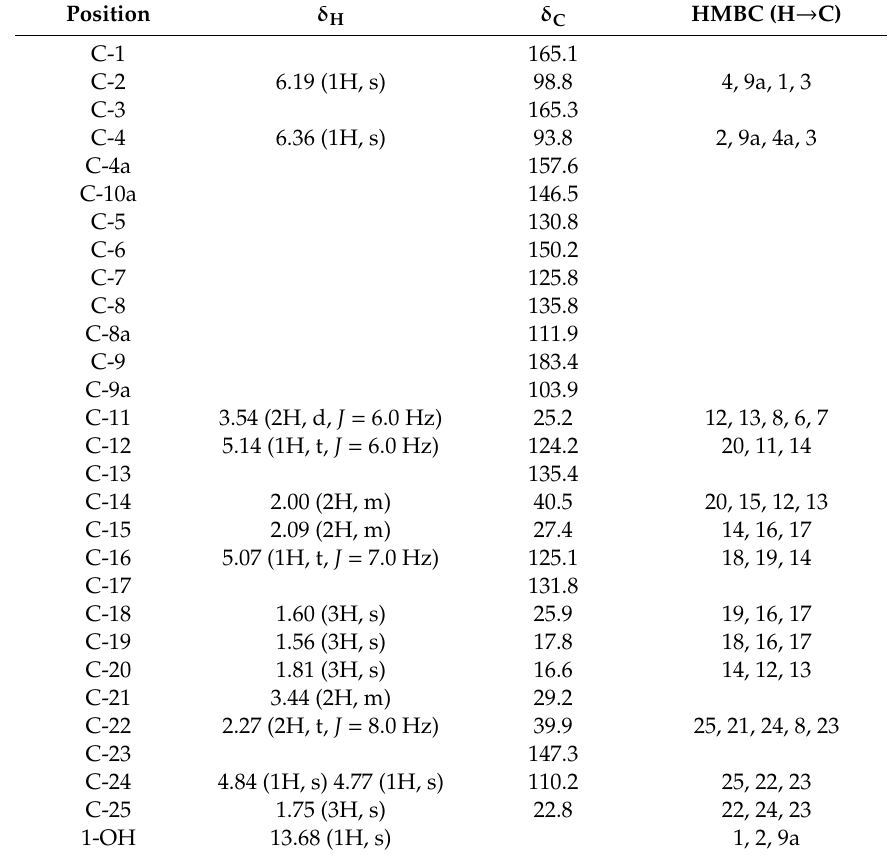
Table 1. 1 H NMR (500 MHz), 13 C NMR (125 MHz) and HMBC data of compound 1 (Acetone- d 6 ) 1